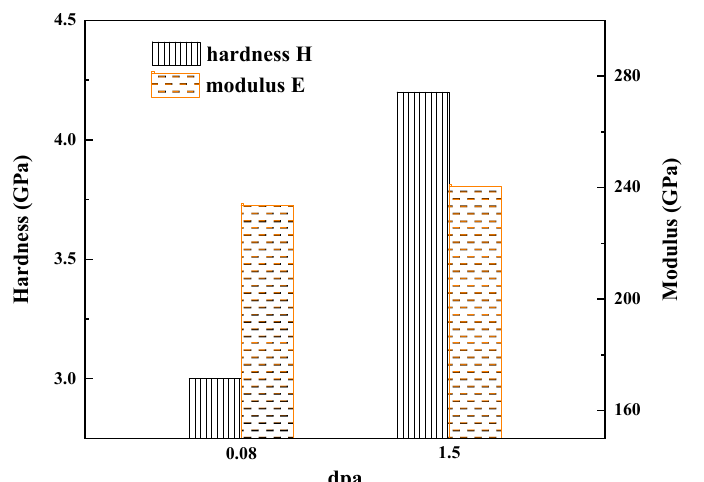
Figure 8. Histogram of hardness and elastic modulus vs dpa for RPV steel with damage levels of 0.08 and 1.5 dpa. The hardness and elastic modulus were detected by nanoindentation using the continuous stiffness method.